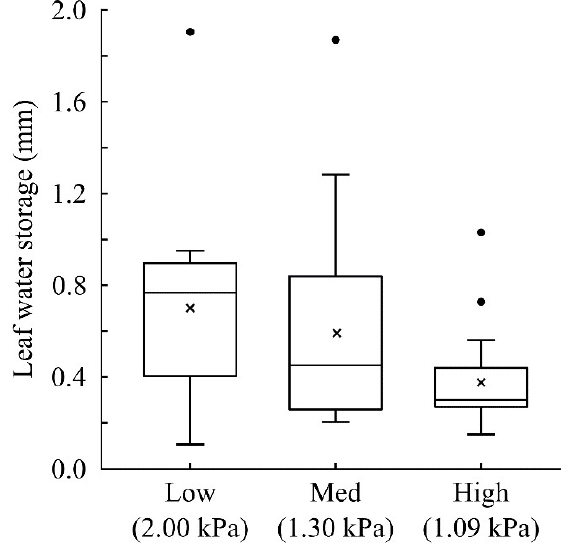
Figure 7. Leaf water storage of vascular epiphyte communities in three cloud-affected forests in a tropical montane region in Monteverde, Costa Rica. Maximum vapor pressure deficit for each site is provided parenthetically. The site labelled “Low” is a pre-montane rainforest, the middle elevation site (“Med”) is near the cloud base, and the “High” site is a 1600 m cloud forest on the Atlantic slope of the continental divide. In each site, 15–30 species were measured ( n > 5 individuals per species). The mean is indicated by an “x”, the median by a line, the 25%–75% quartile by the box, the maximum and minimum of the non-outlier range by the whiskers, and any outliers are shown as dots.